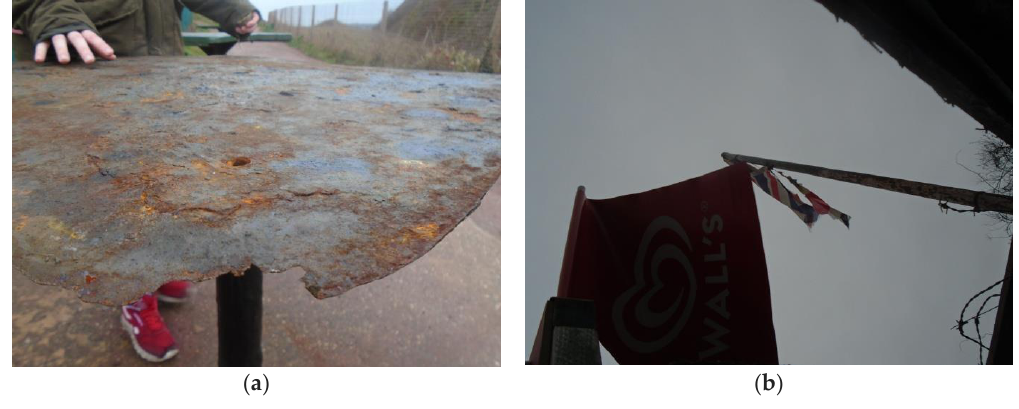
Figure 20. ( a ) Rusting table; ( b ) Shredded flag.